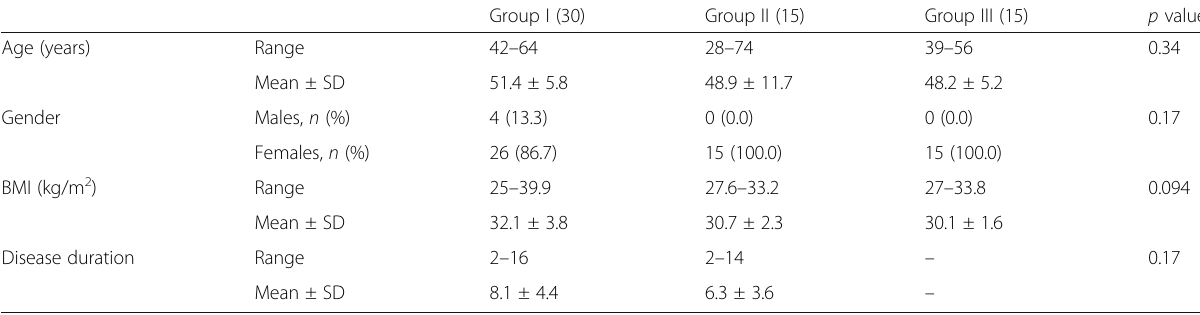
Table 1 Demographic data of the studied groups; showing no statistically significant difference regarding age, gender, BMI between the 3 groups and also insignificant statistical difference in the disease duration between the 2 groups